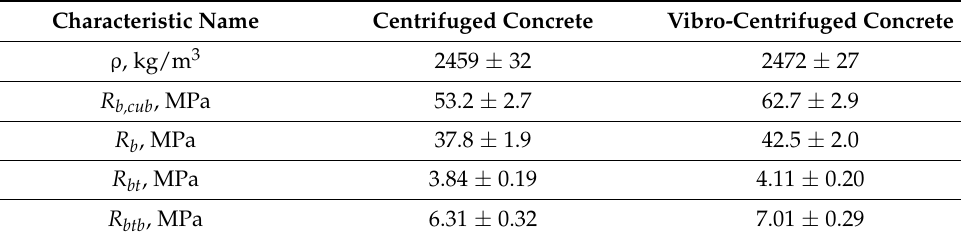
Table 5. Integral strength characteristics.